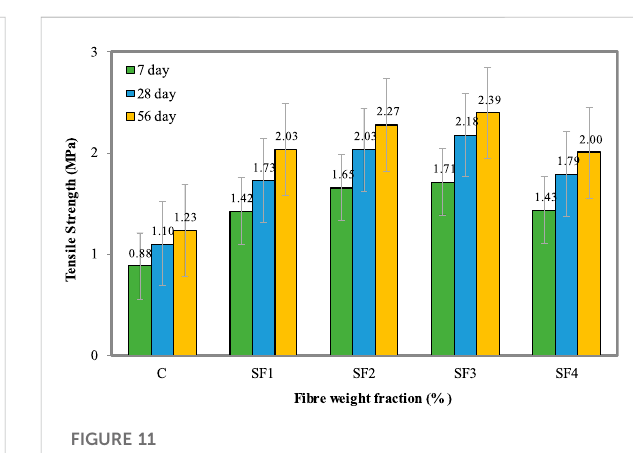
FIGURE 8 Flexural strength of 1,300 kg/m 3 FC density with varying weight fractions of SF.